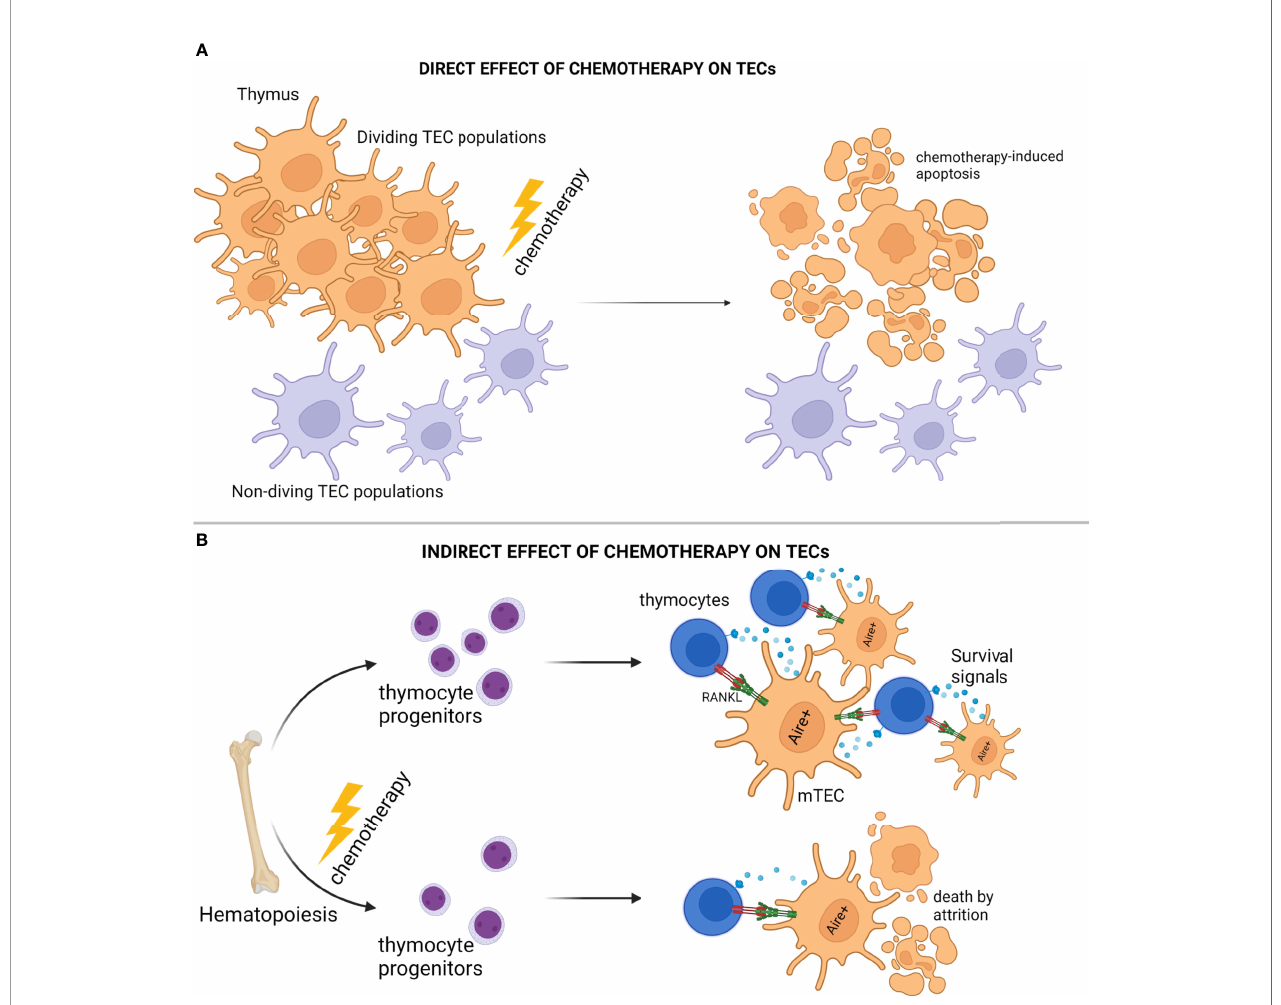
FIGURE 2 | Modes of Thymic Epithelial Cell Death After Chemotherapy Treatment. (A) Cytoreductive chemotherapy non-speci fi cally and unconditionally targets proliferation niches in the entire organism, and as such, insults TEC subsets in the act of cell division. (B) Cytoreductive chemotherapy suppresses bone marrow hematopoiesis and subsequent early thymocyte progenitor homing in the thymic microenvironment, thus disrupting thymocyte-derived prosurvival signals essential for TEC homeostasis, and causing “ attritional ” cell death to sensitive TEC subsets (e.g., AIRE + mTEC). Illustration designed with Biorender